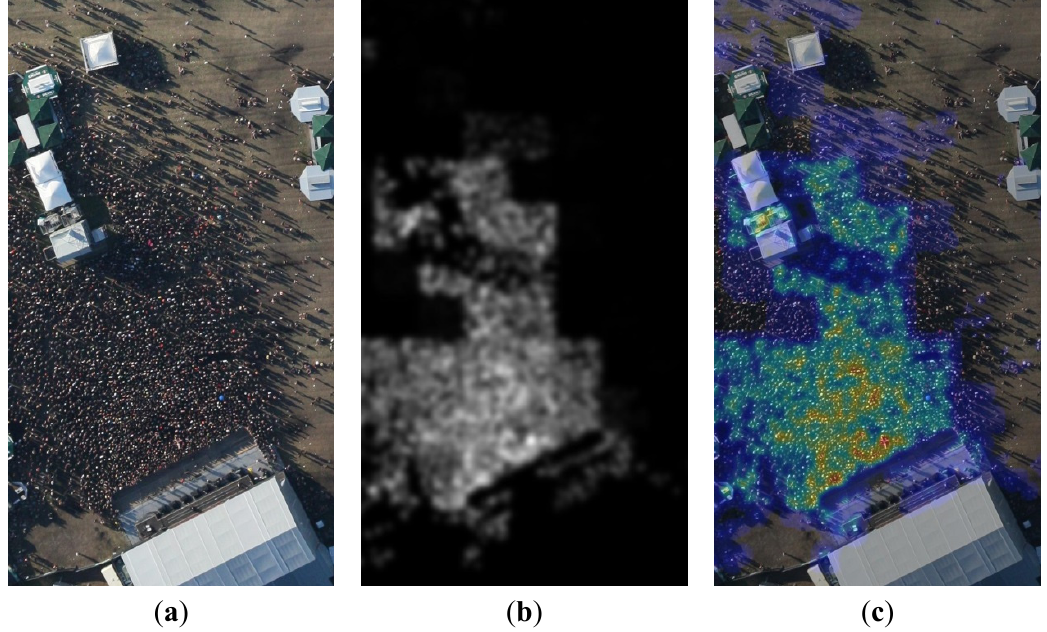
Figure 6. Image ( a ) shows a subset of an unprocessed aerial image from a music festival with a dense crowd standing in front of a stage. Image ( b ) is the computed crowd density layer as a gray value image (black = low density, white = high density). For illustration purposes we created a composite image ( c ), where the density is laid onto the original image (blue = low density, red = high